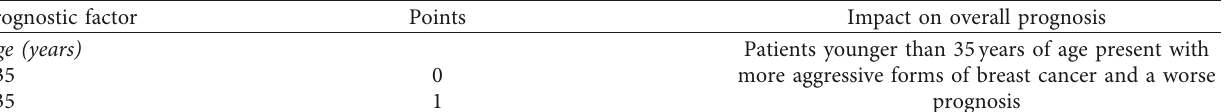
Table 1: Prognostic score calculations for breast cancer patients at disease